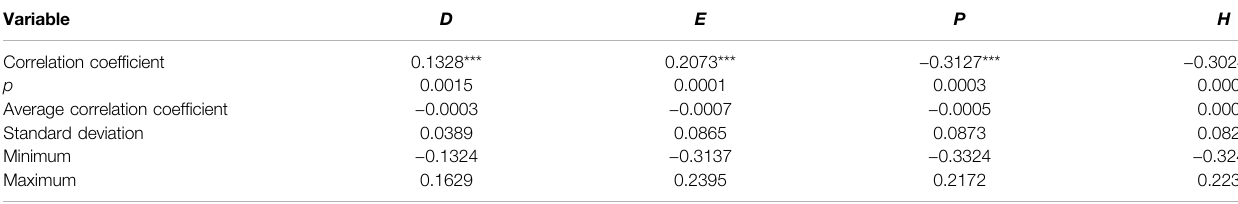
TABLE 2 | Test results of the QAP correlation of the spatial matrix of the information entropy of the carbon emission structure. Variable